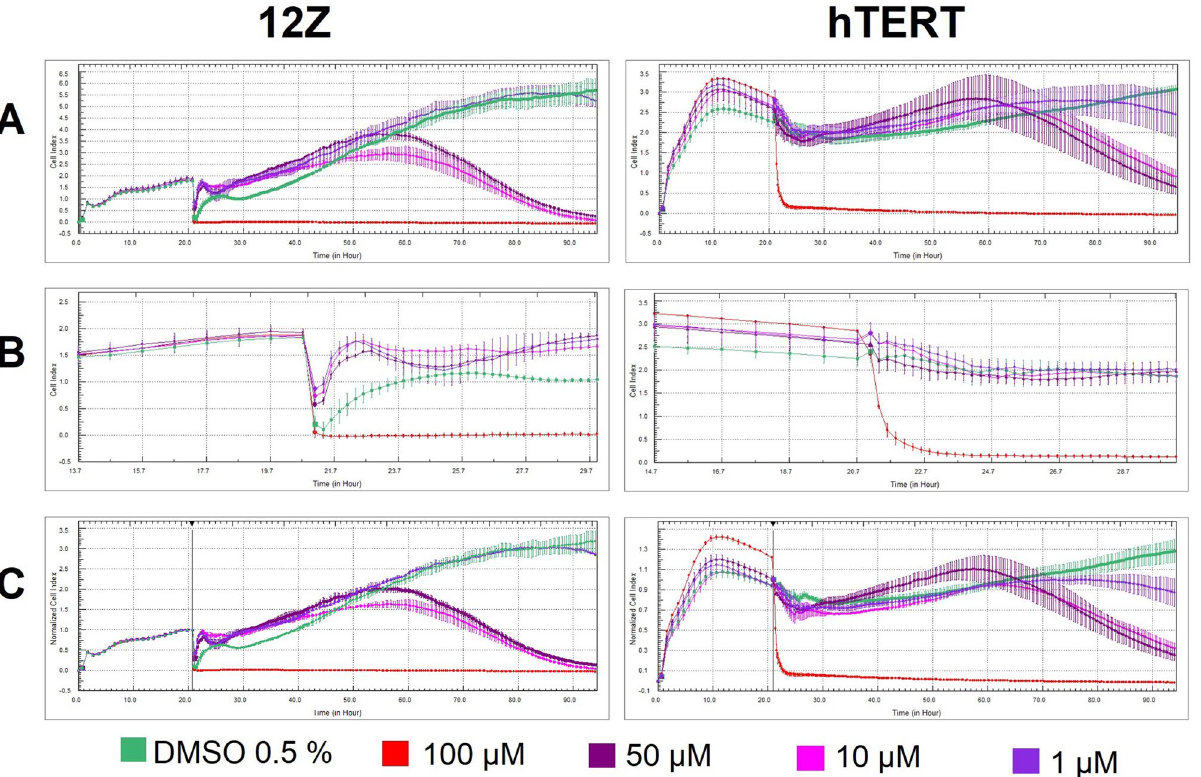
Figure 3. Cell Index (CI) and Normalized Cell Index (nCI) for 12Z and hTERT cells affected with [Zn( neo ) ( nif ) 2 ] (experimental cells) and 0.5% DMSO (control cells). Data from xCELLigence RTCA SP system. ( A ) Cell Index raw data; ( B ) Detail of short time period prior to and following the addition of complex; ( C ) Normalized Cell Index raw